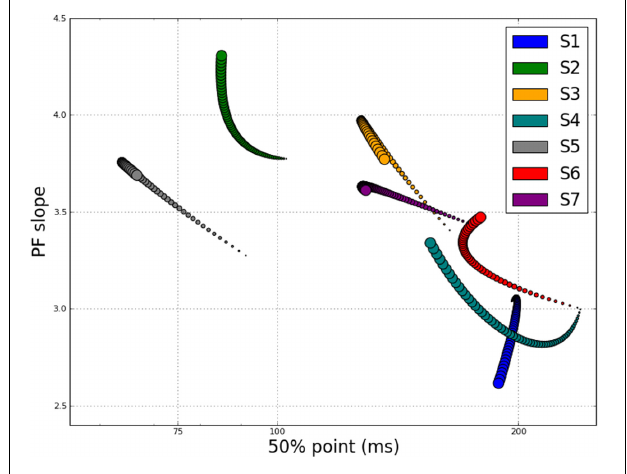
FIGURE 5 | Slope of PF vs. 50% point for each block of each participant, showing evolution throughout training. Color indicates participant, with circle size going from small to large over course of training.